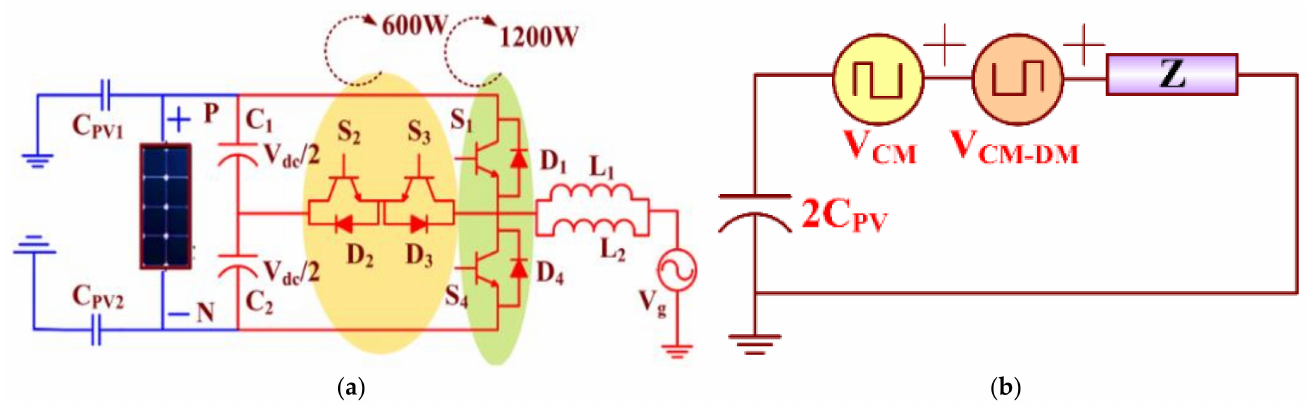
Figure 1. Power Circuit ( a ) Power circuit of single-phase transformer-less TNP-MLI. ( b ) Common-mode voltage model equivalent circuit single-phase transformer-less